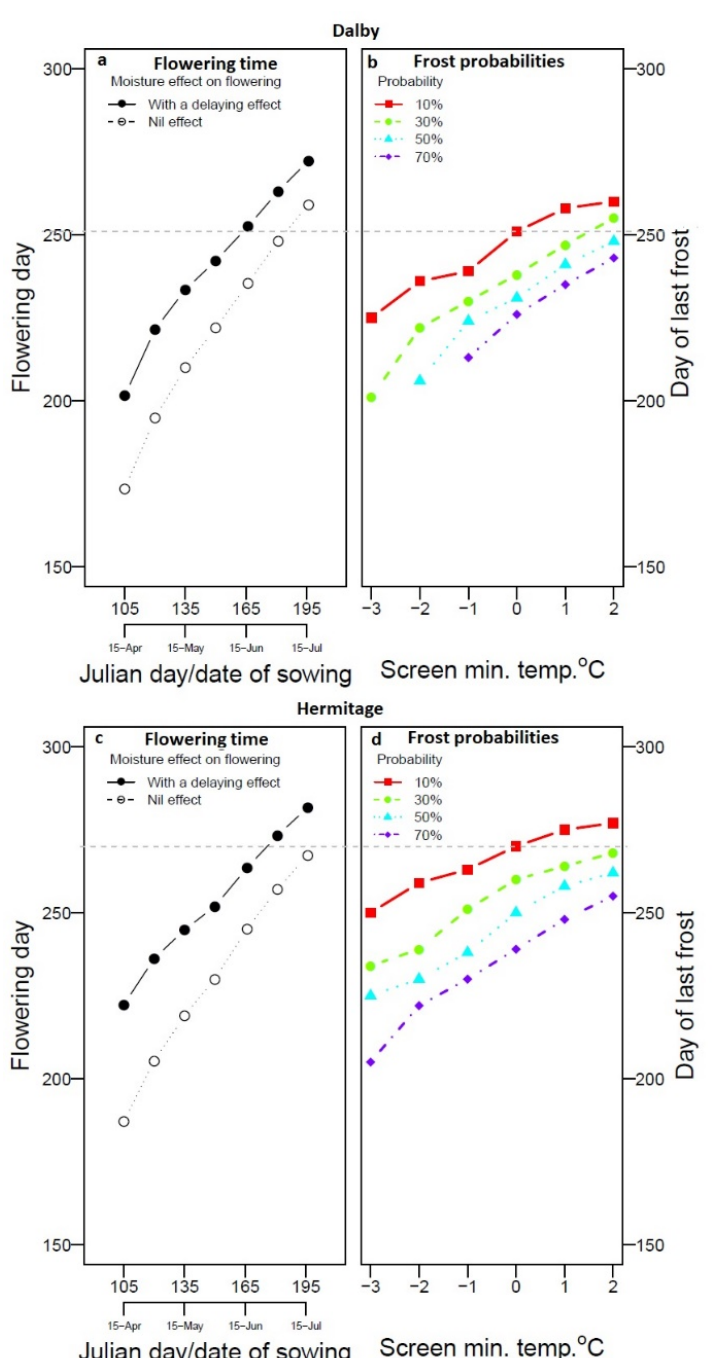
Figure 5. Simulated Julian day of flowering after accounting for soil water effect ( a ) represented by a solid line and solid symbols and without accounting for soil water effect (original Agricultural Production Systems Simulator (APSIM) model) as dotted line with open symbol) as a function of planting date (15 April = day 105; 15 July = day 195) for PBA Boundary (dark lines) at Dalby (a) and Hermitage (Warwick, c) in Darling Downs and Southern Downs, respectively. The coloured lines in the right panel for each location (panel b for Dalby and d for Hermitage) represent corresponding frost probabilities based on the entire temperature record of 1961 to 2017 for a range of screen temperatures (2 °C to –3°C) expressed as the probability of falling below a specified temperature threshold after a certain date (‘Julian day of last frost’). The horizontal dashed grey lines in each panel indicate the planting date that corresponds to a 10% frost risk probability based on the Stevenson screen temperature of 0 °C.